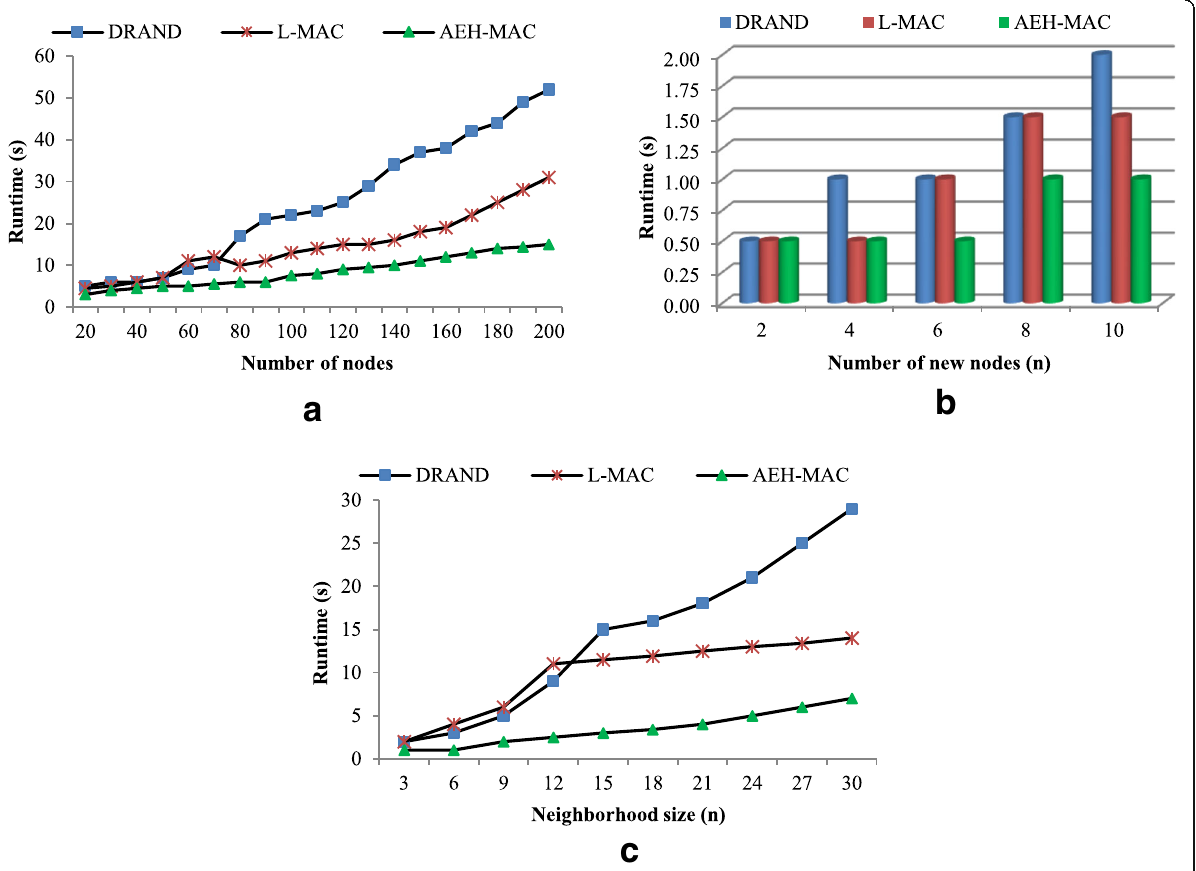
Fig. 10 Runtime during slot assignment: ( a ) Nodes vs. Runtime ( b ) New nodes vs. Runtime ( c ) Neighborhood size vs.